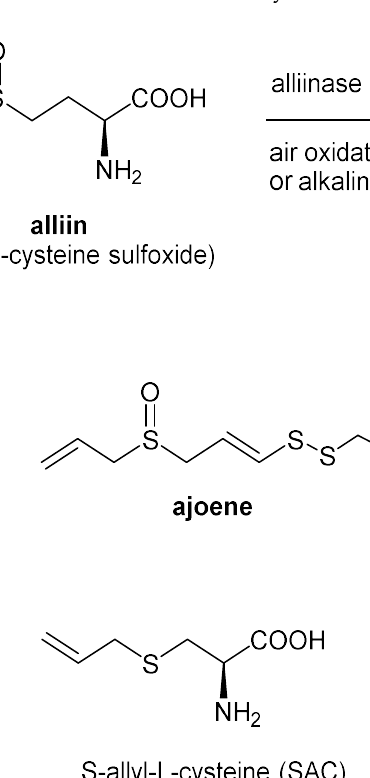
Figure 1. Structures of eucalyptol and jensenone, the active components of eucalyptus oil.